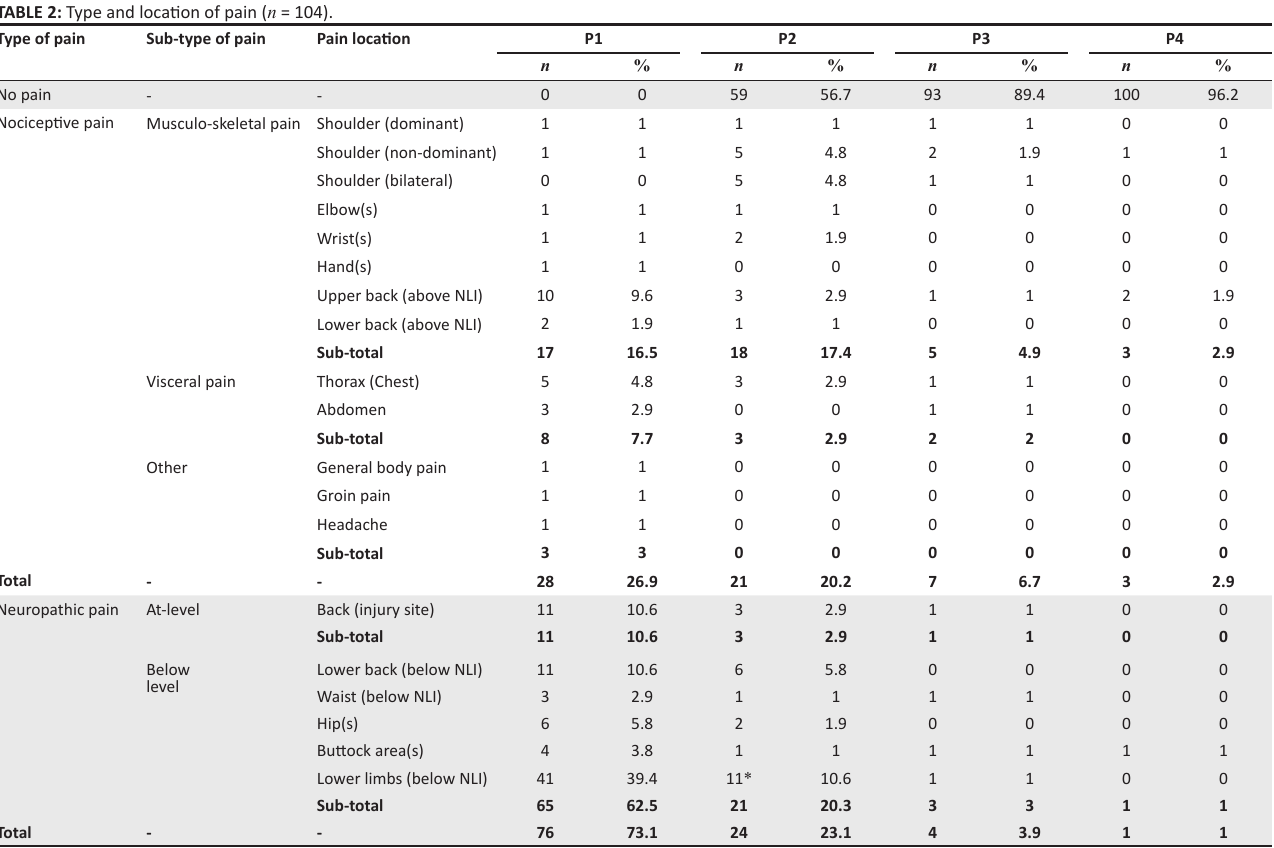
TABLE 2: Type and location of pain ( n =